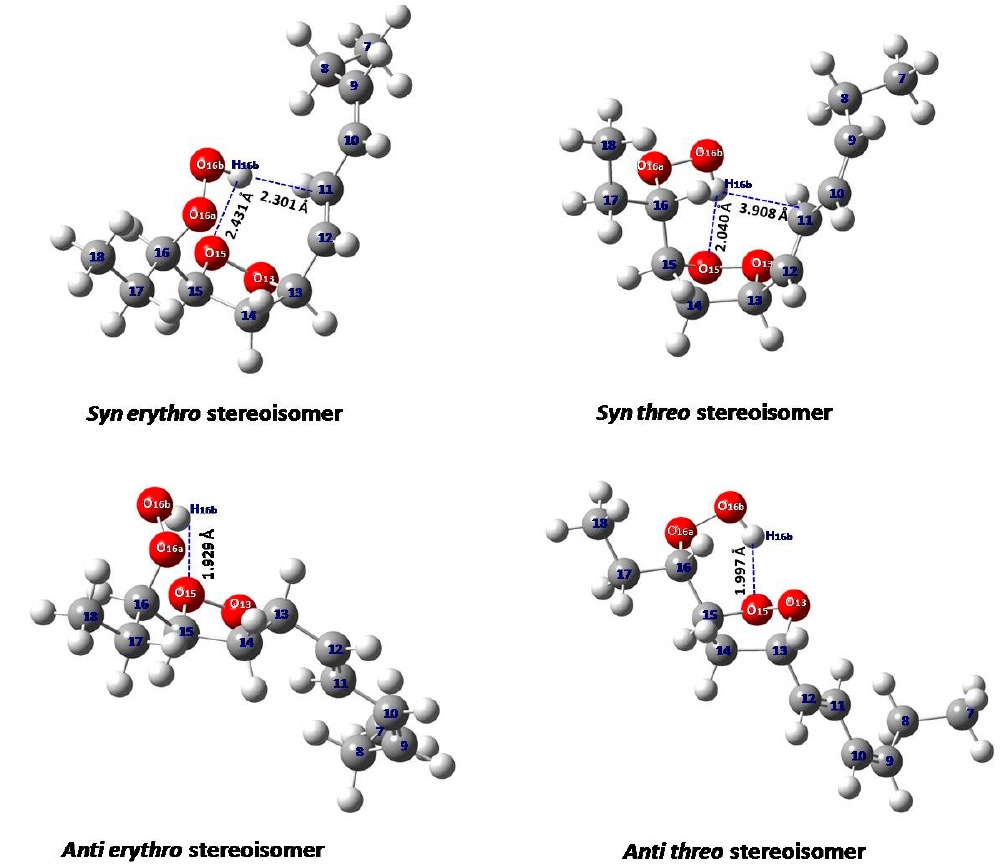
Figure 9. Minimum energy structures of two pairs of diastereomers of 9- cis , 11- trans -16-OOH endo -hydroperoxide models in integral equation formalism polarizable continuum model (IEFPCM) (CHCl 3 ).